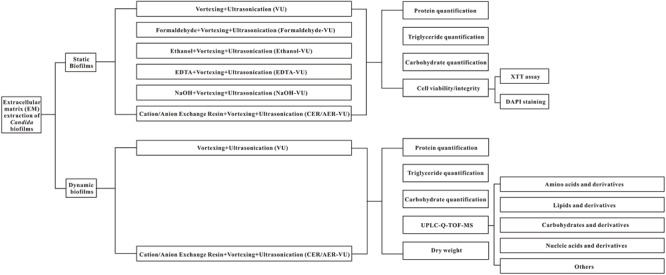
Schematic flowchart of the EM extraction metabolite profiling used in this study.